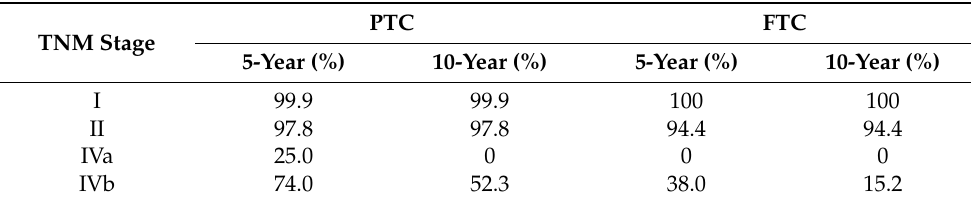
Table 2. Cancer-specific 5-year and 10-year survival (%) for PTC and FTC according to AJCC/UICC TNM staging system (8th edition).